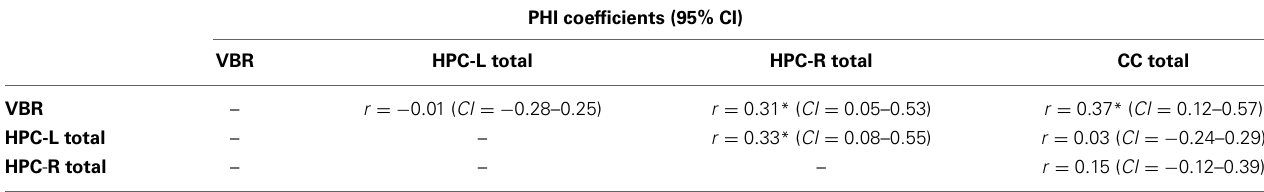
Table 5A | PHI coefficients across the structures measured.